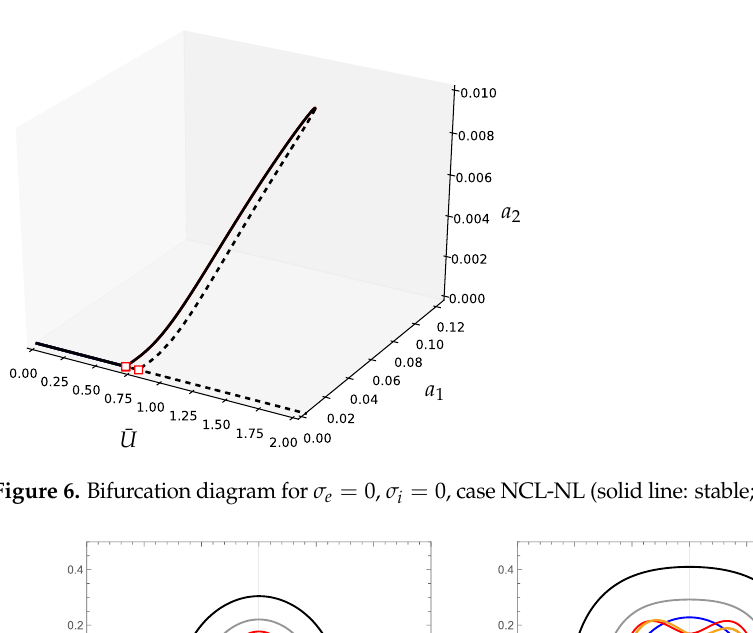
Figure 5. Bifurcation diagram for σ e = 0, σ i = 0: ( a ) amplitude a 1 ; ( b ) amplitude a 2 (solid line: stable; dashed line: unstable).